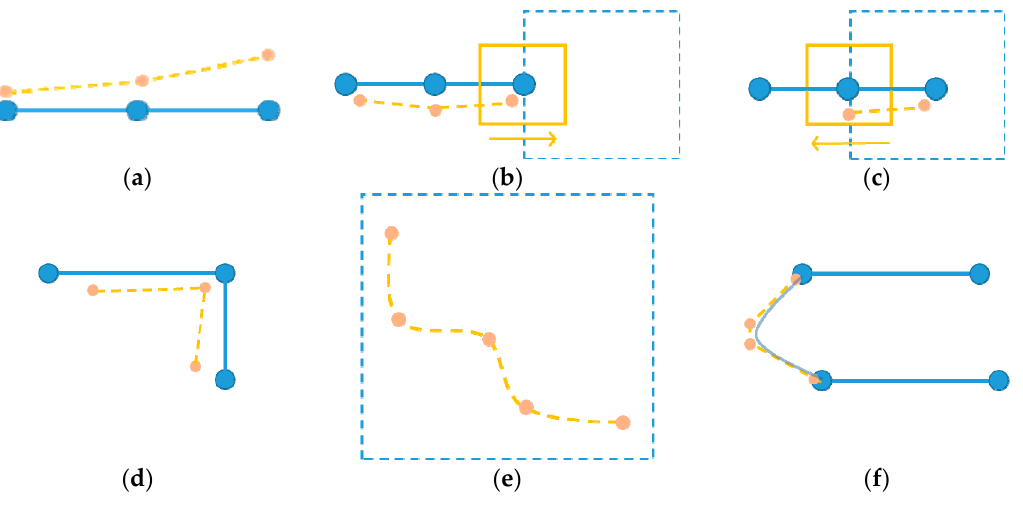
Figure 6. User motion: ( a ) corresponds to M1, ( b ) corresponds to M2, ( c ) corresponds to M3, ( d ) corresponds to M4, ( e ) corresponds to M5, ( f ) corresponds to M6. The blue line roughly depicts the space structure, and the dashed yellow line simulates the real user walk through the spaces.